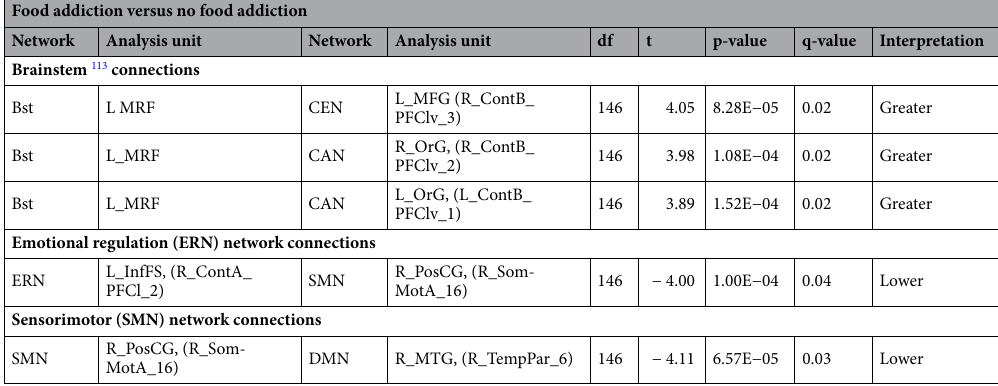
Table 3. Resting state pairwise connections in individuals with food addiction compared to individuals with no food addiction. Summarizes significant disease-related differences in functional connectivity (individuals with food addiction vs. individuals with no food addiction). All connections are significant q < 0.05. Bst, Brainstem; CAN, Central Autonomic Network; CEN, Central Executive Network; DMN, Default Mode Network; ERN, Emotional Regulation Network; InfFS, Inferior frontal sulcus; MFG, Middle frontal gyrus; MRF, Mesencephalic reticular formation; MTG, Middle Temporal Gyrus; OrG, Orbital gyri; PosCG, Postcentral Gyrus; SMN, Sensorimotor Network. df: degrees of freedom; p value significant < .05, q value (corrected for multiple comparisons) <